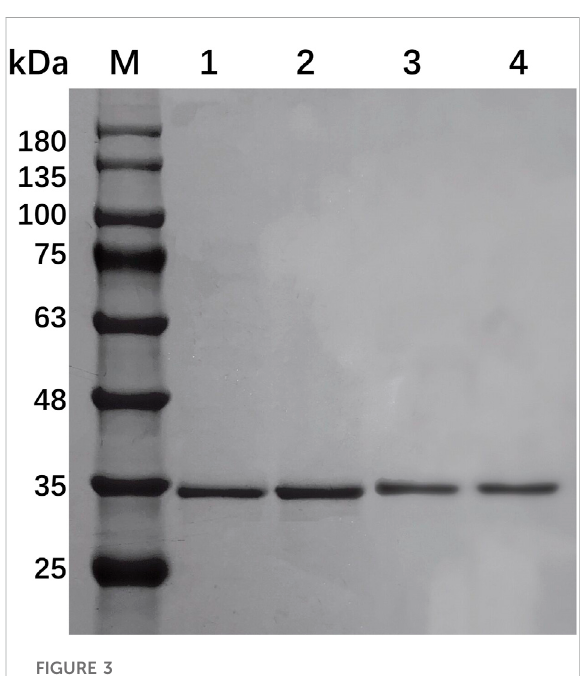
FIGURE 3 SDS-PAGE of EcsXyl1 – EcsXyl4 puri fi cation steps. Lane